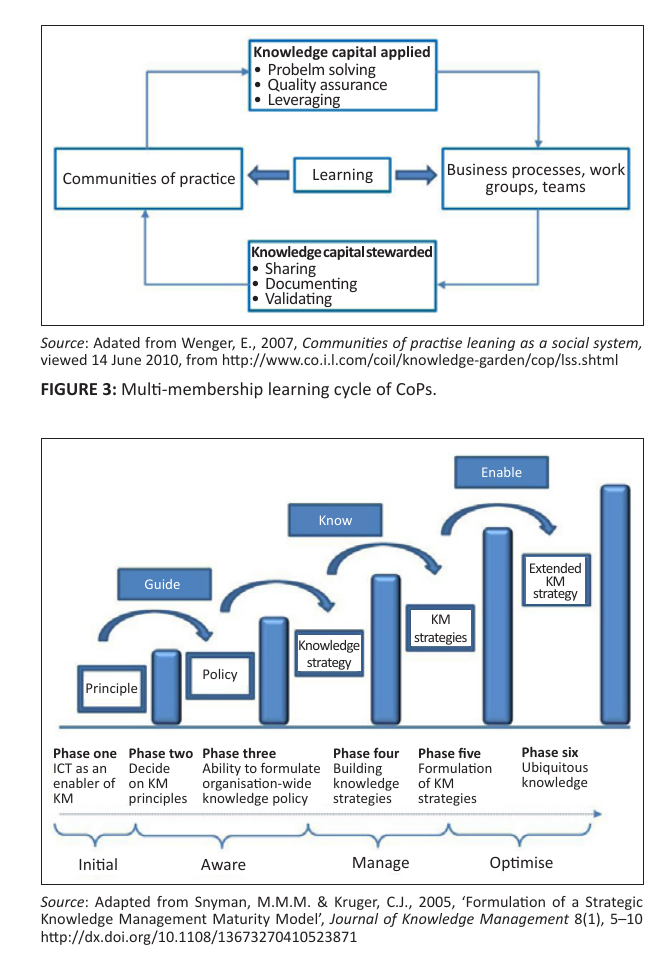
FIGURE 4: Strategic knowledge management maturity model.